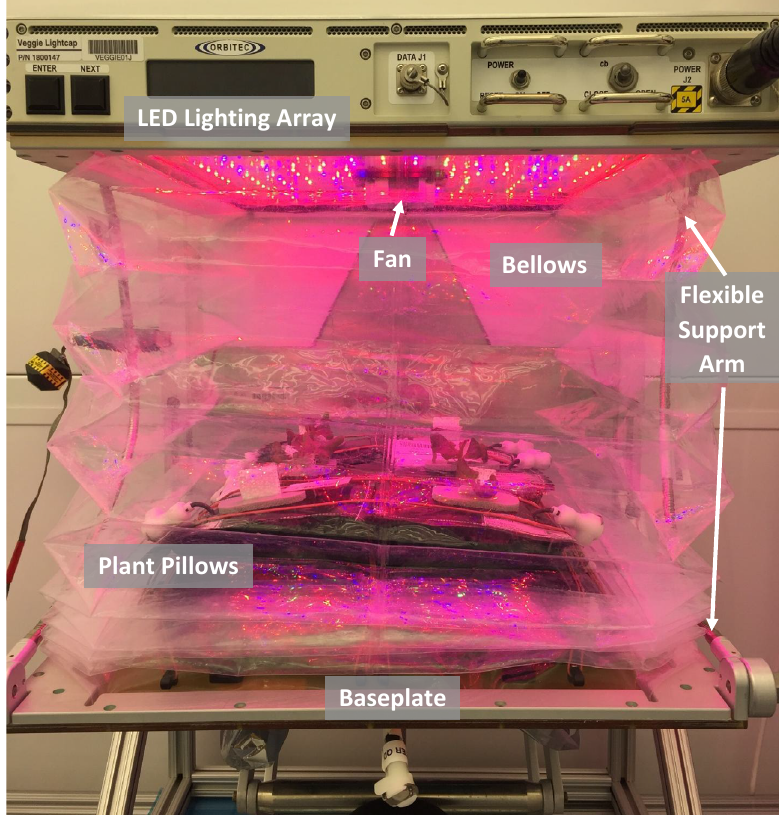
Figure 1. Image of the Veggie hardware during ground testing. Image shows Veggie powered light cap and controls with flexible transparent bellows containing plant pillows. Eighteen day-old red romaine lettuce plants are growing in plant pillows. The Veggie baseplate is 29.2 cm wide by 36.8 cm deep with a maximum available shoot height of an empty chamber of 47 cm. With the reservoir maximum shoot height is 41.9 cm.